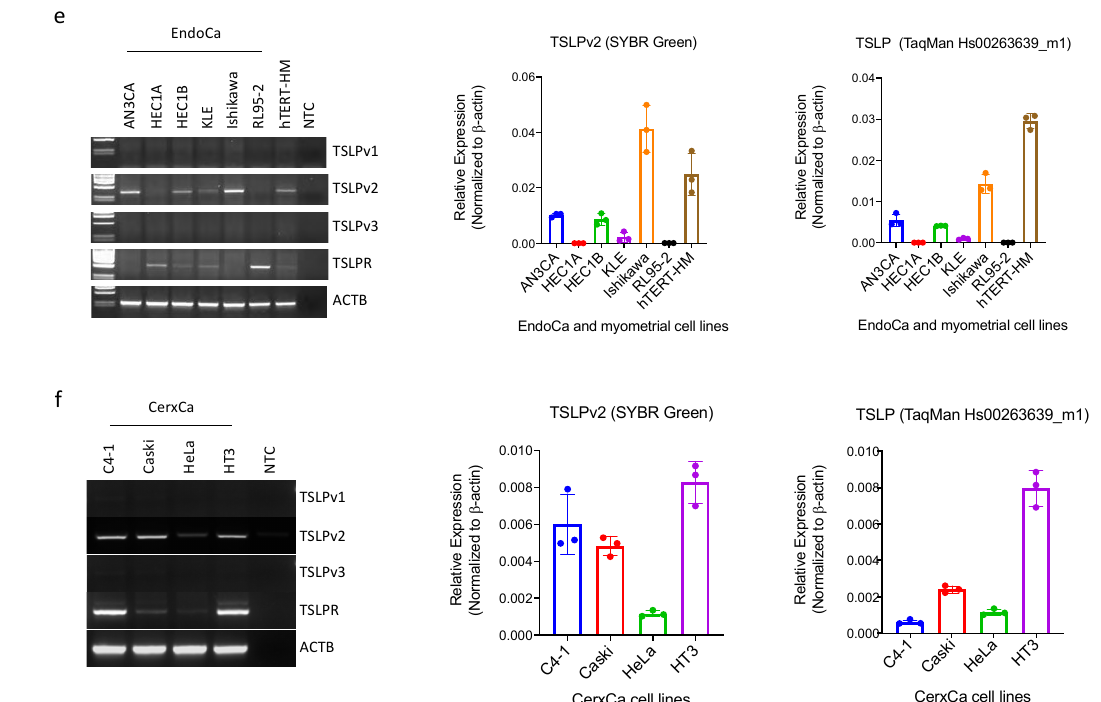
Figure 1. Short-form thymic stromal lymphopoietin (sfTSLP), but not long-form thymic stromal lymphopoietin (lfTSLP), was expressed in the human cell lines of ovarian, endometrial and cervical cancer. ( a ) Schematic representation of the human TSLP locus (5q22.1) from the UCSC Genome Browser (hg18). Primers for RT-PCR of TSLPv1 (NM_033035), TSLPv2 (NM_138551) and TSLPv3 (NR_045089) are labelled as blue arrows; primers and probes of TaqMan expression assay for TSLP (Hs00263639_m1) are labelled as red arrows. A CpG island located at the promoter region and exon 1 of TSLPv2 gene is labelled as green bar. ( b ) RT-PCR of TSLP isoforms (TSLPv1, TSLPv2 and TSLPv3) and TSLPR in 5 non-malignant human immortalised ovarian surface epithelial (IOSE), 2 non-malignant immortalised human fallopian tube secretory tube epithelial (FTSEC) and 16 human ovarian cancer (OvCa) cell lines. β-actin (ACTB) served as house-keeping gene controls. The ACTB controls for IOSE, FTSEC and OvCa cell lines in Figure 1b,d are identical since they are part of the same original RT-PCR experiments with different primer sets of interest. The figures are organized as shown to better align with the data presented in the Result Section; NTC: No template controls. ( c ) Real-time quantitative RT-PCR (qRT-PCR) of TSLPv2 in IOSE, FTSEC and OvCa cell lines was performed by SYBR green assay with TSLPv2-specific primers (upper panel) and qRT-PCR of TSLP was performed by TaqMan expression assay for TSLP (Hs00263639_m1; lower panel). ( d ) RT-PCR of lfTSLP (TSLPv1) and sfTSLP (TSLPv2) in IOSE, FTSEC and OvCa cell lines. Primers specific for lfTSLP and sfTSLP were designed by Fornasa et al. and Biancheri et al. [29,30]. ( e ) mRNA expression of TSLP isoforms (TSLPv1, TSLPv2 and TSLPv3) and TSLPR in 6 human endometrial cancer cell lines (EndoCa) and an immortal human myometrial stromal cell line (hTERT-HM) was examined by RT-PCR (left panel) and qRT-PCR (middle panel: SYBR green assay for TSLPv2; right panel: TaqMan expression assay for TSLP). ( f ) mRNA expression of TSLP isoforms (TSLPv1, TSLPv2 and TSLPv3) and TSLPR in 4 human cervical cancer cell lines (CerxCa) was examined by RT-PCR (left panel) and qRT-PCR.